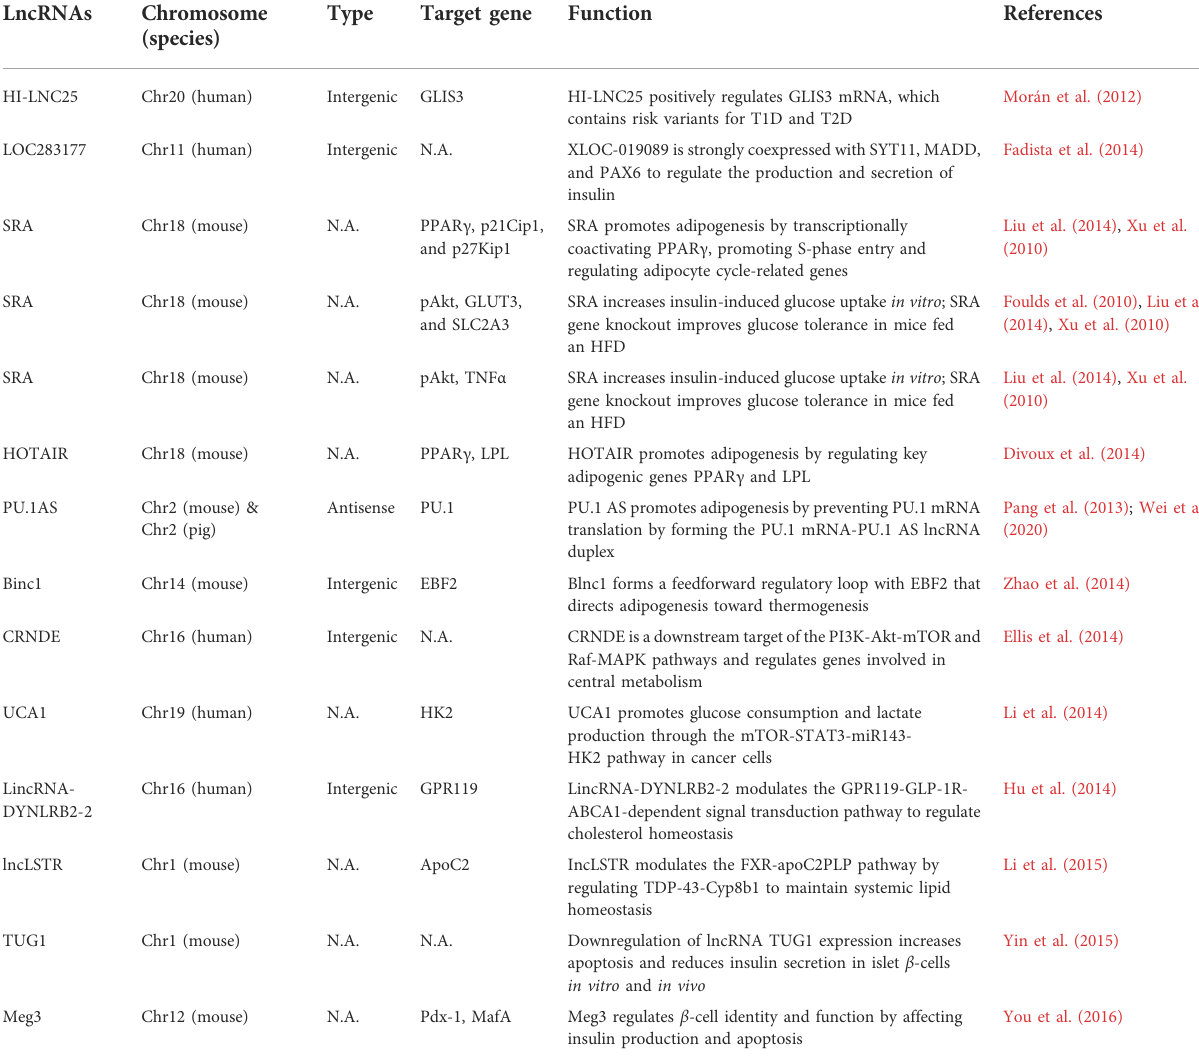
TABLE 1 LncRNAs are involved in the occurrence and development of diabetes. Adapted with permission from (Feng et al., 2017). Copyright 2016, Biochemistry and Cell Biology.